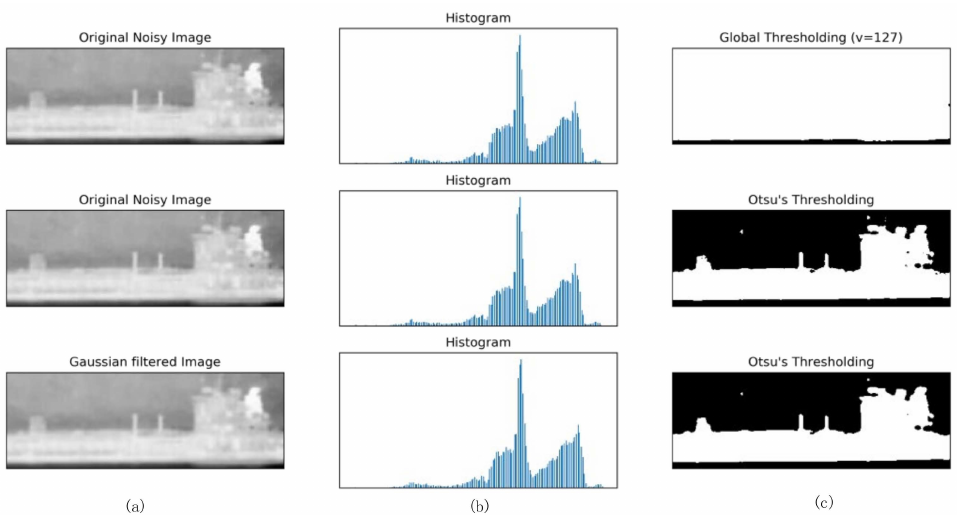
Figure 6. Comparison of infrared image binarization. ( a ) input images. ( b ) histogram. ( c ) Processing results of